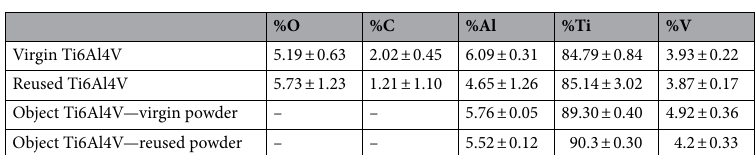
Table 4. Results of EDX analysis on virgin and Ti6Al4V reused powder (after sieving) and objects built from these powders. All results are given in weight